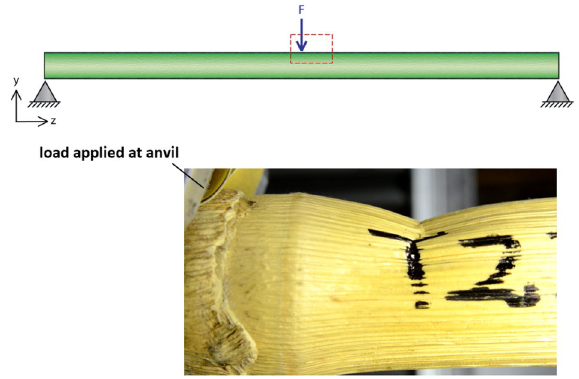
Figure 1. ( Top) Stalks were tested in three-point bending. (Bottom): Stalks failed due to localized (Brazier) buckling in the area of the stalk immediately above the loaded